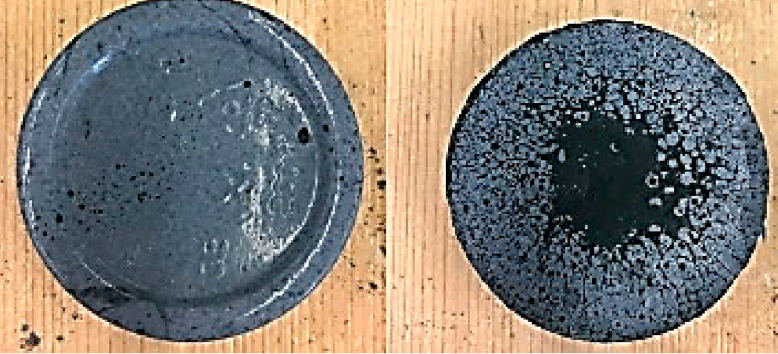
Figure 2. MK100 + 70%Biochar sample at 90 curing